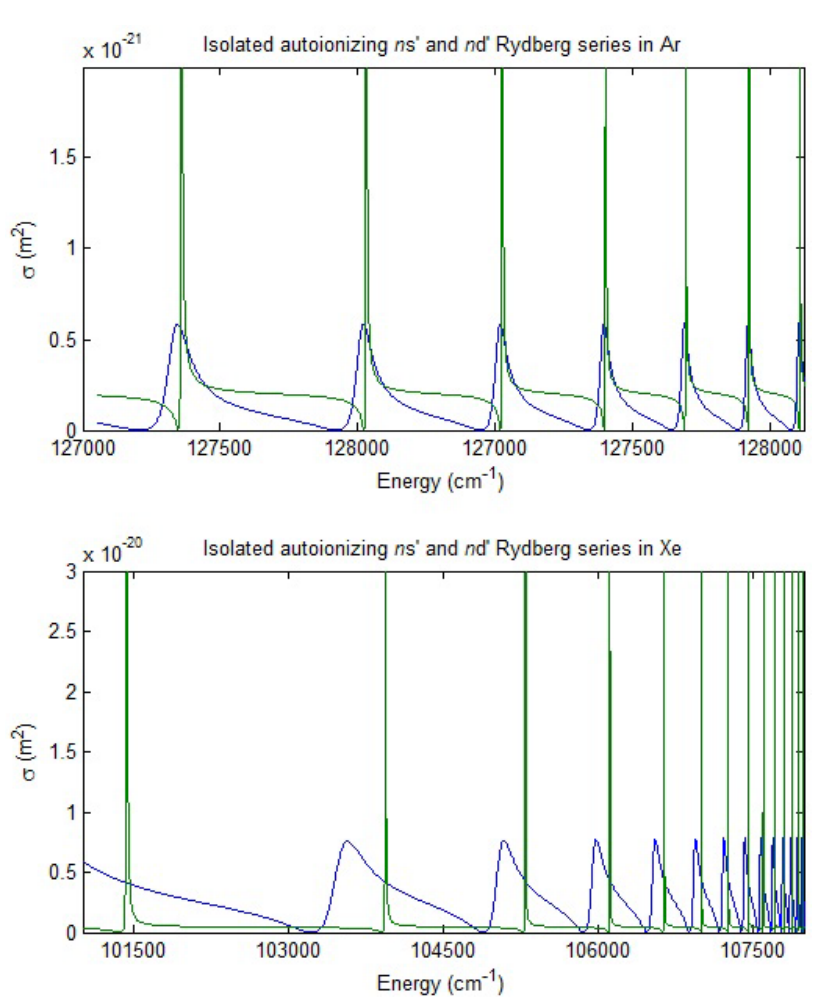
Figure 12. Isolated autoionizing Rydberg series for Ar and Xe: ns’ drawn with dotted and nd’ with solid lines. (from [29]).